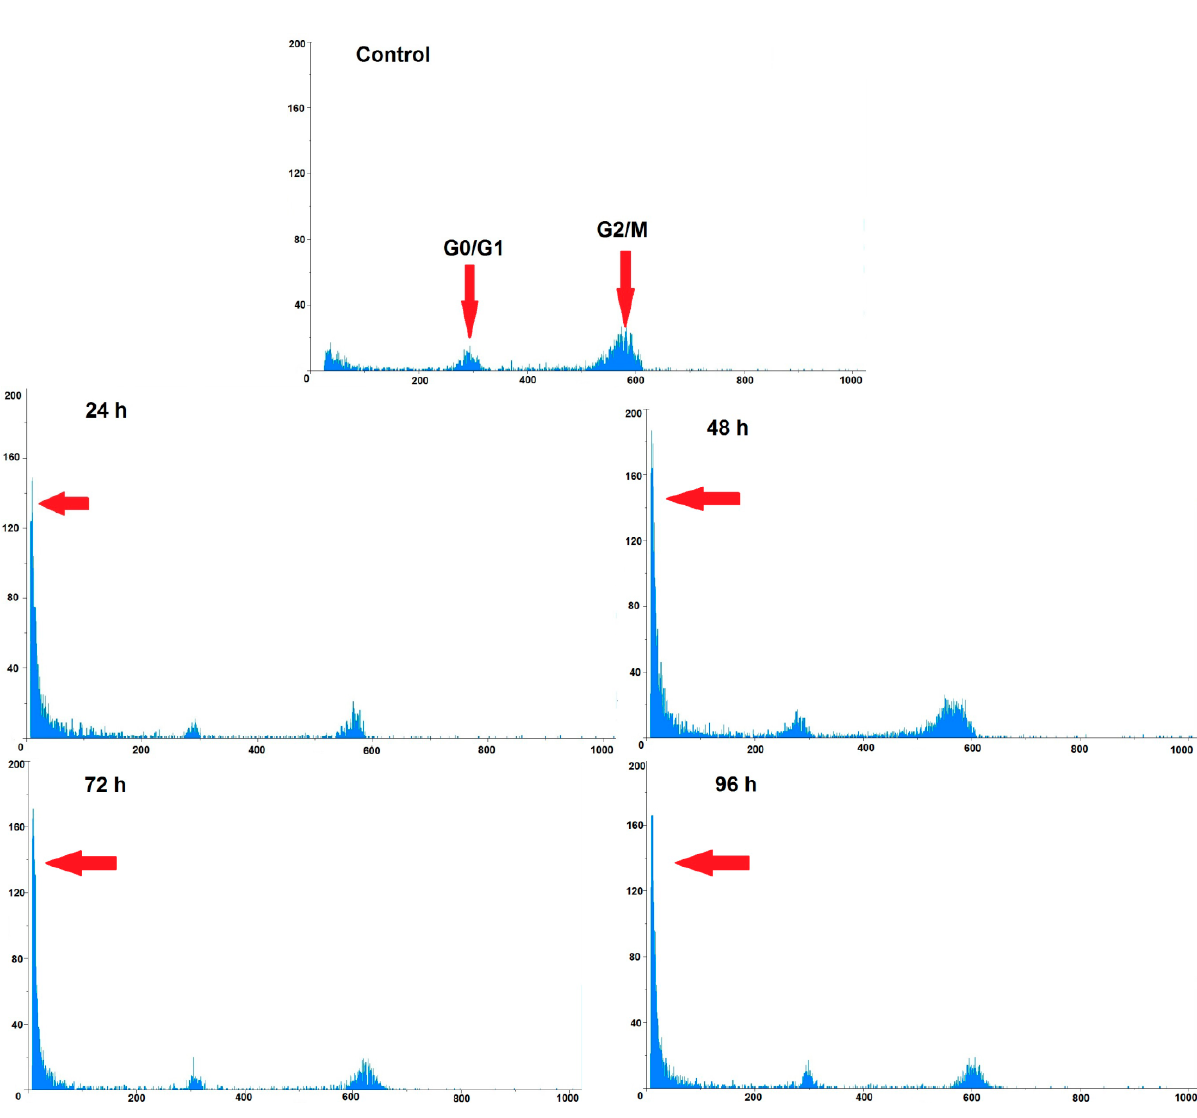
Figure 7. DNA fragmentation of control and 100 µM AlCl 3 treated barley roots at long term exposure. (x) axis denotes cell counts and (y) axis denotes fluorescence